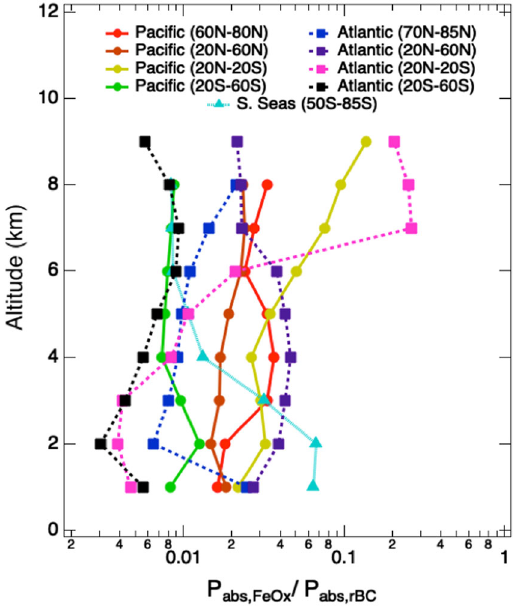
Fig. 8 Relative shortwave atmospheric heating rates. Altitude- dependent instantaneous shortwave atmospheric heating rates (300 – 2500 nm) for anthropogenic FeO x -like LAM relative to rBC for each of the regions in cloud-free air. Calculated shortwave heating rates are based on observed mass concentrations and size distributions as well as theoretical calculations for the altitude- dependent actinic fl ux in each